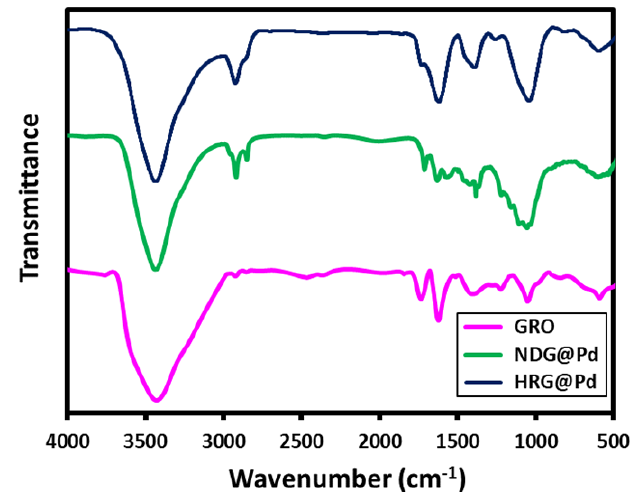
Figure 2. FT-IR spectra of graphene oxide (GRO) (pink line), highly reduced graphene-based palladium nanocatalysts (HRG@Pd) (blue line), and nitrogen-doped graphene-based palladium nanocatalyst (NDG@Pd) (green line).